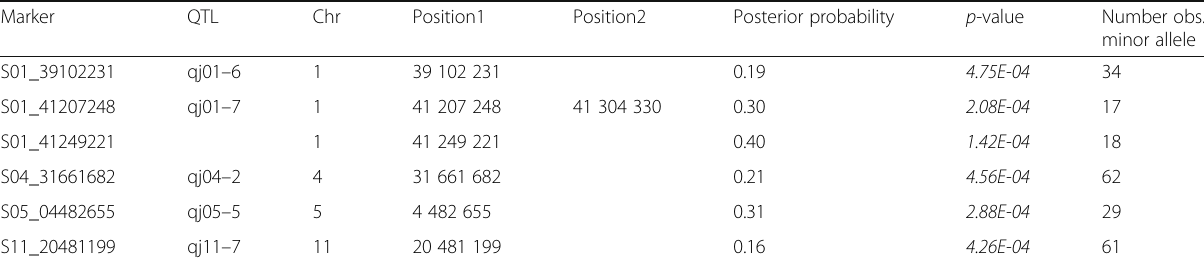
Table 7 Markers significant in the GBS japonica panel excluding the 10 extreme lines with very wide root cone angles Marker QTL Chr